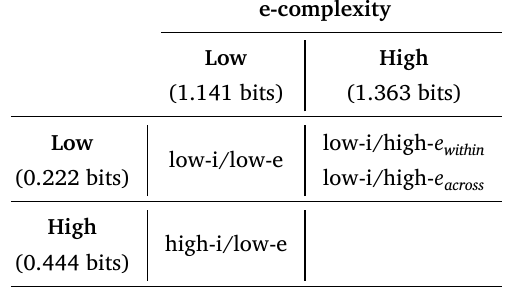
Table 3: Four target paradigms differing either in i-complexity or e-complex- ity values. The low i-complexity, low e-complexity (low-i/low-e) and high i- complexity, low e-complexity (high-i/low-e) paradigms differ in i-complexity only. The two remaining low-i/high-e paradigms have low i-complexity but have higher e-complexity; these paradigms also differ in the type of syncretism pattern (within class or across